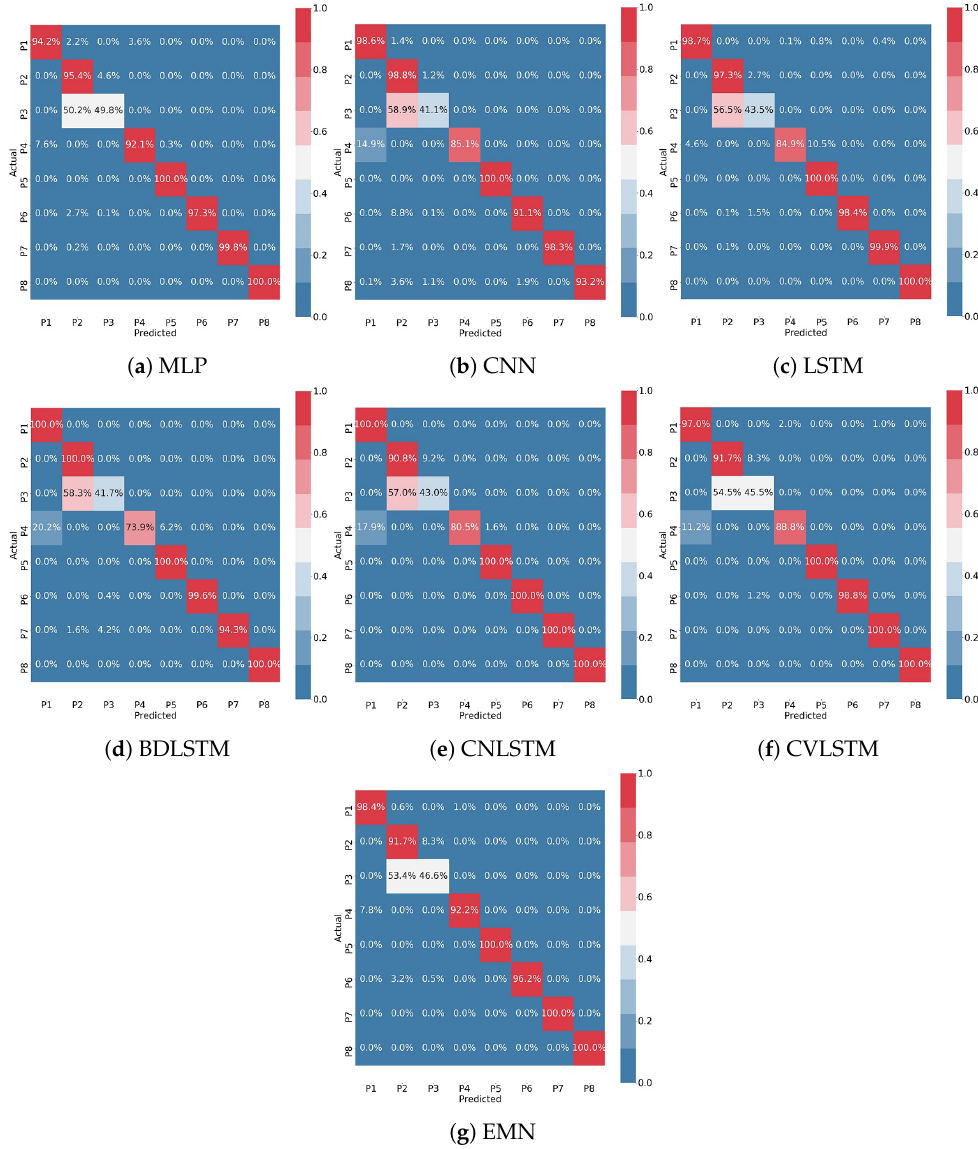
Figure 13. Confusion matrices of 8 postures classification results for 7 DL models, evaluated by 5-fold cross validation. All CMs show the result of k = 1